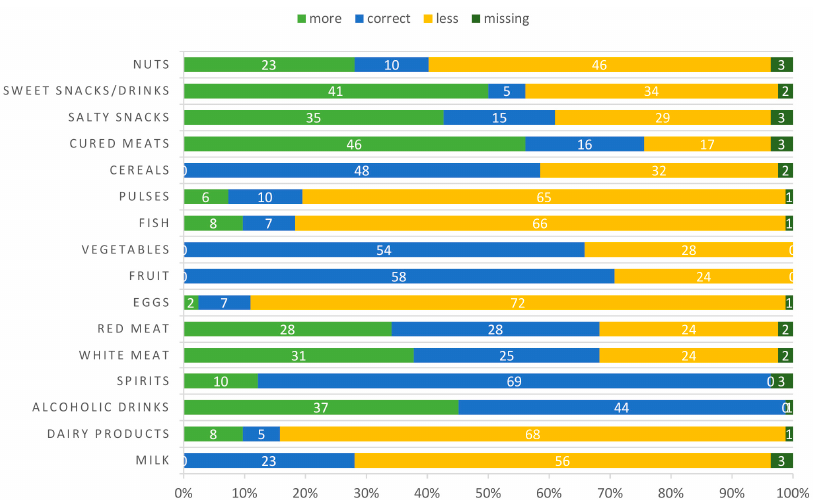
Figure 1. Distribution of patients’ food consumption frequencies compared to an ideal healthy diet. “Missing” indicate that no responses were provided. White numbers in the bar represent number of patients. Table 3. Median of weekly frequency of patients’ food consumption. Range in the brackets.